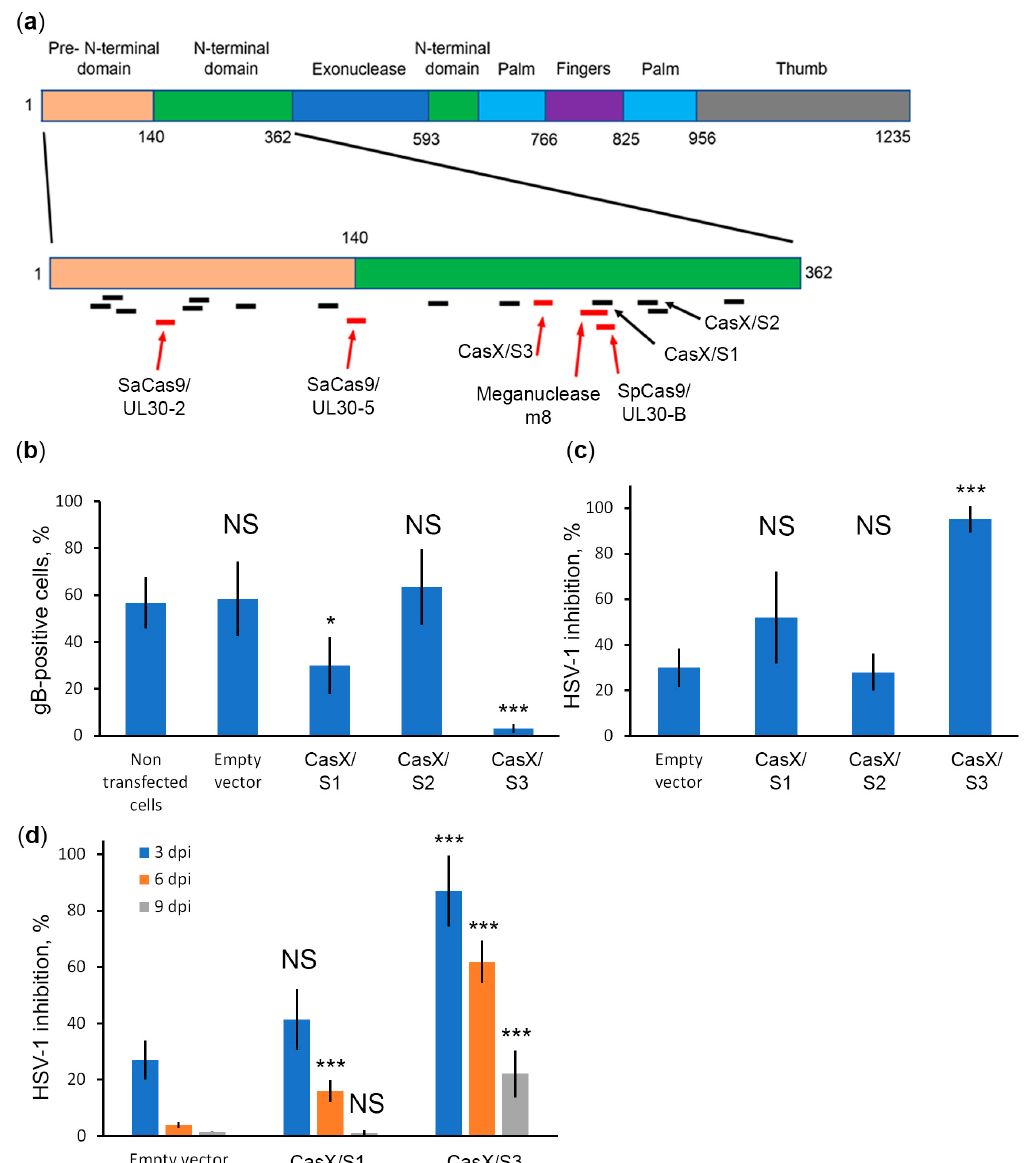
Figure 3. UL30 -targeted CRISPR/CasX system effectively controls HSV-1 infection in the Vero cell line. ( a ) Matching the positions of the targets of different genomic editors with the UL30 domains. Information about the structure of UL30 was taken from [46]. Targets highlighted in red are considered efficient, targets highlighted in black are considered inefficient. Corresponding genomic editors and spacer names are indicated for effective targets as well as for the CRISPR/CasX system. ( b ) Anti-HSV-1 activity of CRISPR/CasX plasmids was assessed by gB staining at 2 dpi. Data are given as mean ± SD ( n = 3). ( c ) Evaluation of HSV-1 inhibition rate in Vero cell cultures transfected with CRISPR/CasX plasmids. Data are given as mean ± SD ( n = 3). ( d ) Long-term inhibition of HSV-1 by CRISPR/CasX plasmids in Vero cultures. Cells were infected with HSV-1 at a concentration of 0.1 PFU/mL. Data are mean ± SD ( n =